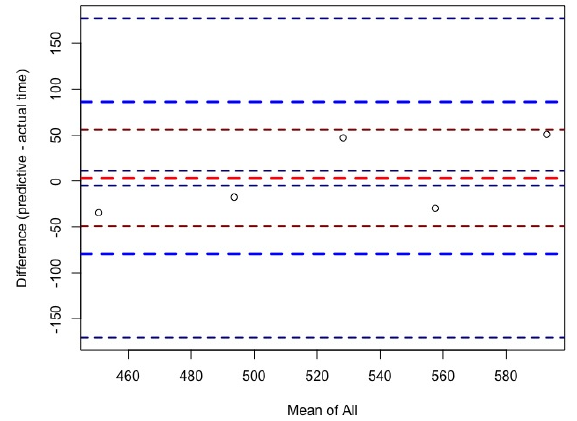
Figure 1. (a) Correlation of predicted women’s ultramarathon times with actual race times; (b) Correlation of predicted men’s ultramarathon times with actual race times.